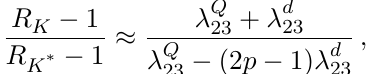
JHEP12(2019)009 (green s